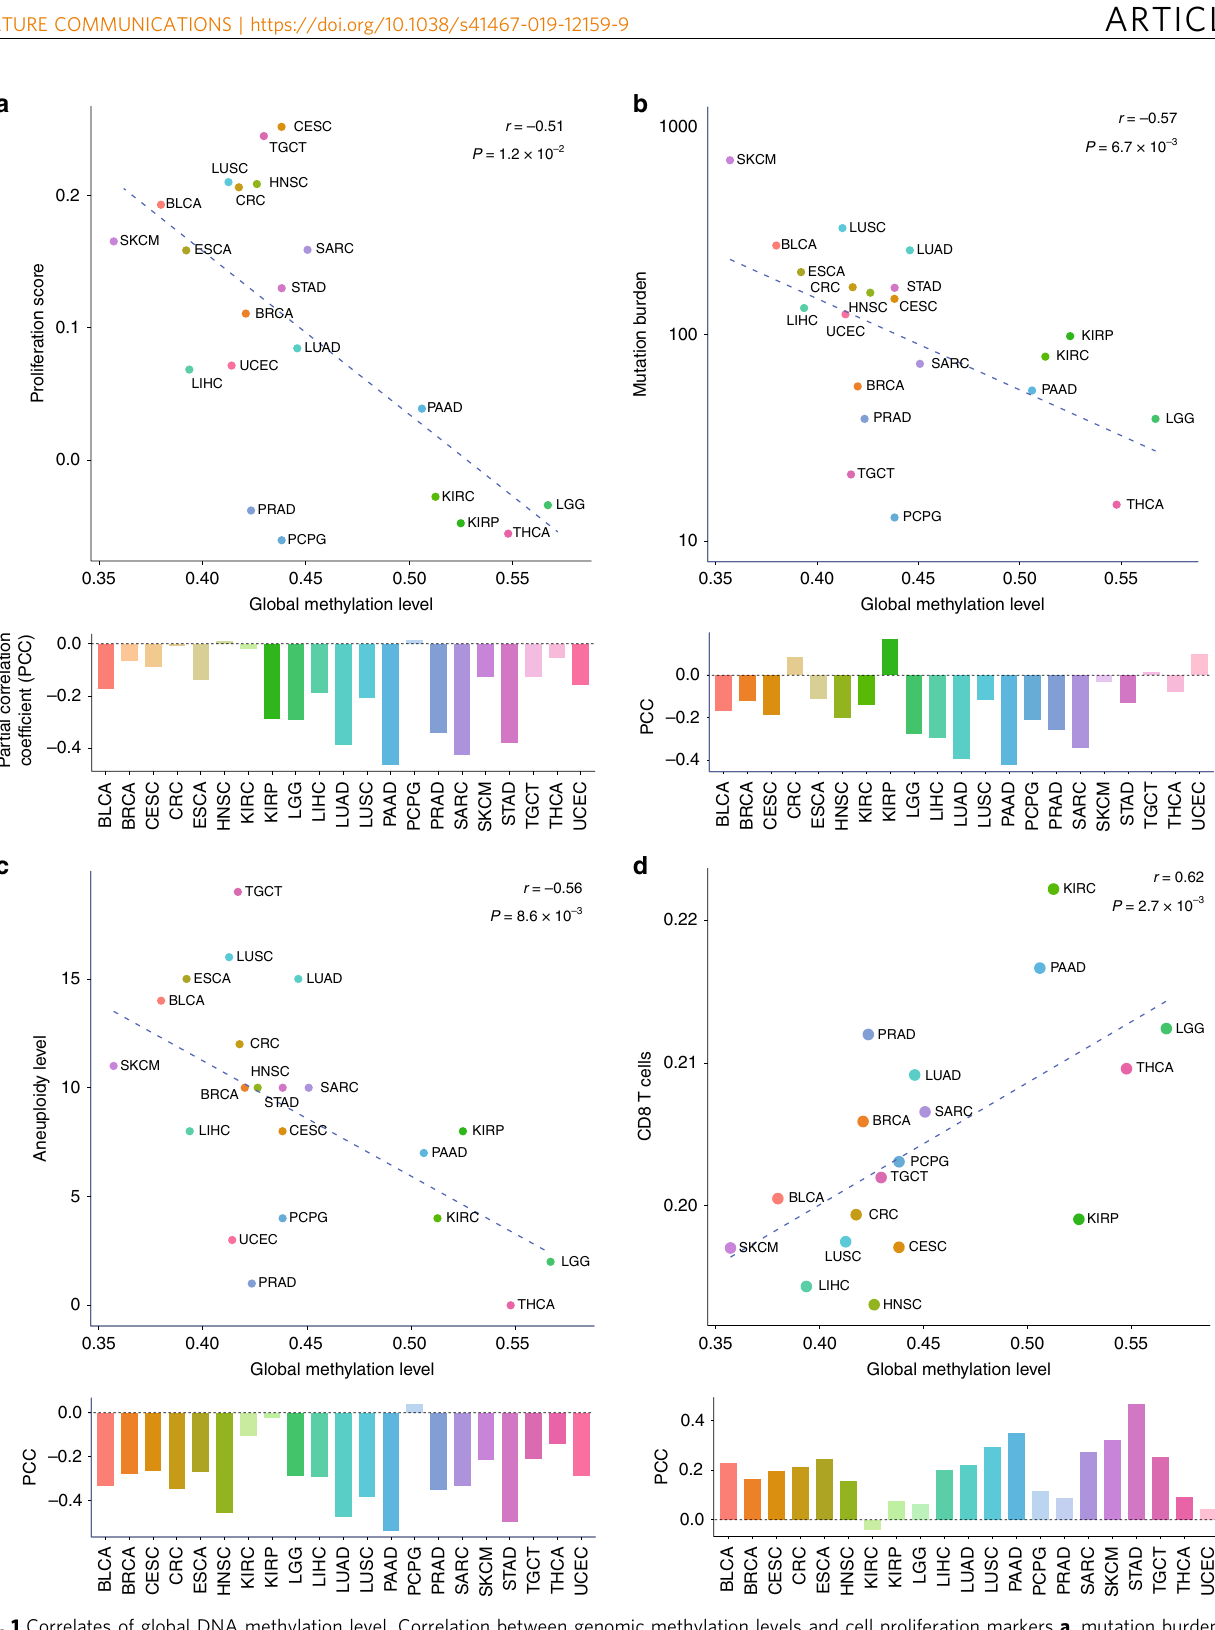
Fig. 1 Correlates of global DNA methylation level. Correlation between genomic methylation levels and cell proliferation markers a , mutation burden b , aneuploidy level c , and tumour-in fi ltrating CD8 + T cell markers d across and within 21 cancer types. a – d The median values were obtained for each cancer type, and statistical signi fi cance was evaluated using Spearman ’ s correlation (upper scatterplots). Three outlier cancer types (ESCA, STAD, and UCEC) are not shown for the CD8 + T cell correlation, but included when evaluating Spearman ’ s correlation. For the correlation within each cancer type (lower bar graphs), Spearman ’ s partial correlation was used to adjust for tumour purity. Tumour types showing signi fi cant partial correlation coef fi cient ( P < 0.05) were shaded in darker